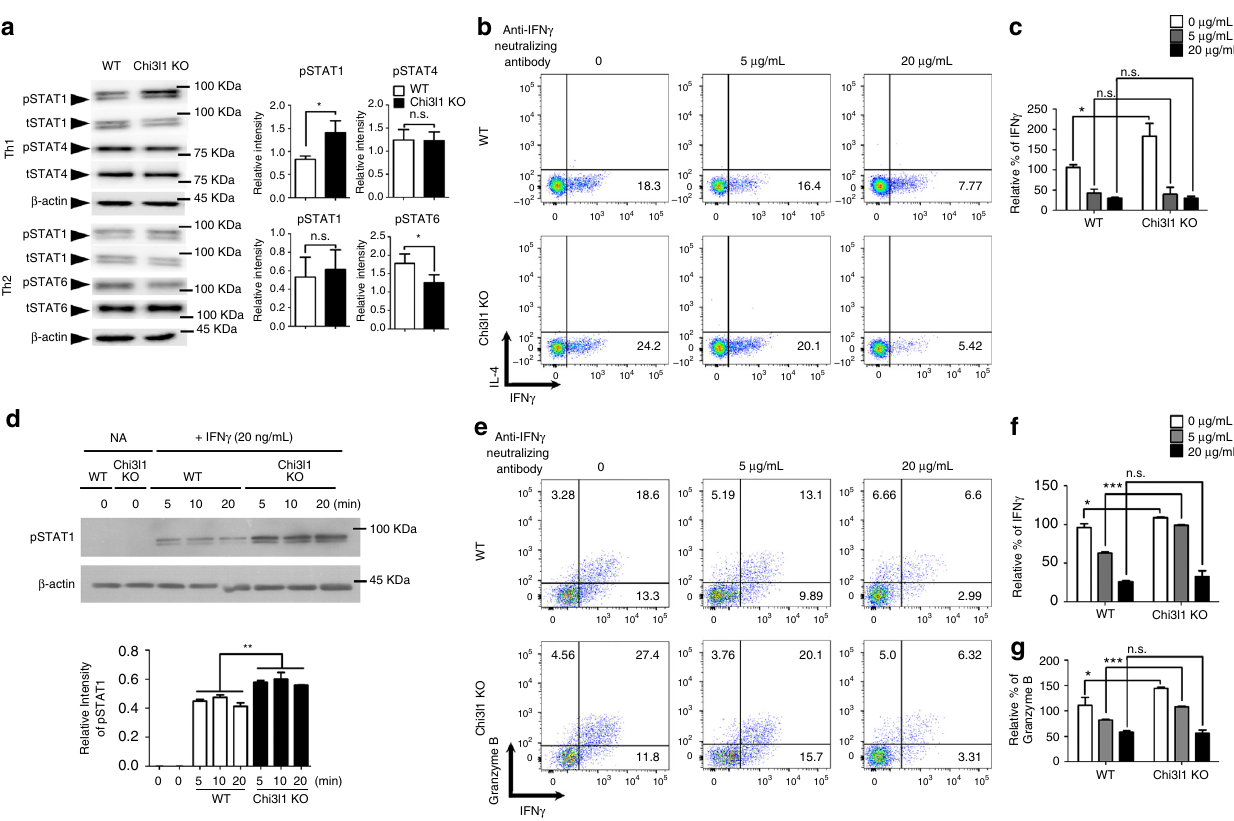
Fig. 4 Increased Th1 and CTL response in Chi3l1 KO T cells are IFN γ dependent. a Phosphorylation of STAT1, STAT4, STAT6 were analyzed by Western blotting. Relative densitometric analysis of Western blotting normalized to total STAT. b WT and Chi3l1 KO naive CD4 T cells were differentiated into Th1 cells with the indicated concentrations of IFN γ neutralizing antibodies and assessed for IFN γ and IL-4 expression by intracellular cytokine staining. c Proportion of IFN γ producing cells were represented by relative % of IFN γ to WT Th1. d FACS-sorted WT and Chi3l1 KO naïve CD4 T cells were treated with IFN γ and pSTAT1 level was analyzed by Western blotting. Densitometric values of band intensity was calculated by normalization to the value of β -actin. e Intracellular level of IFN γ and Granzyme B in CD8 T cells. f Proportion of IFN γ producing cells were represented as relative % of IFN γ to WT CD8 T cells without anti-IFN γ neutralizing antibody. g Proportion of Granzyme B expressing cells were represented as relative % of Granzyme B to WT CD8 T cells without anti-IFN γ neutralizing antibody. Data are mean ± SD of three sets of independent experiments ( n = 6). n.s., not signi fi cant; * p < 0.05, *** p <